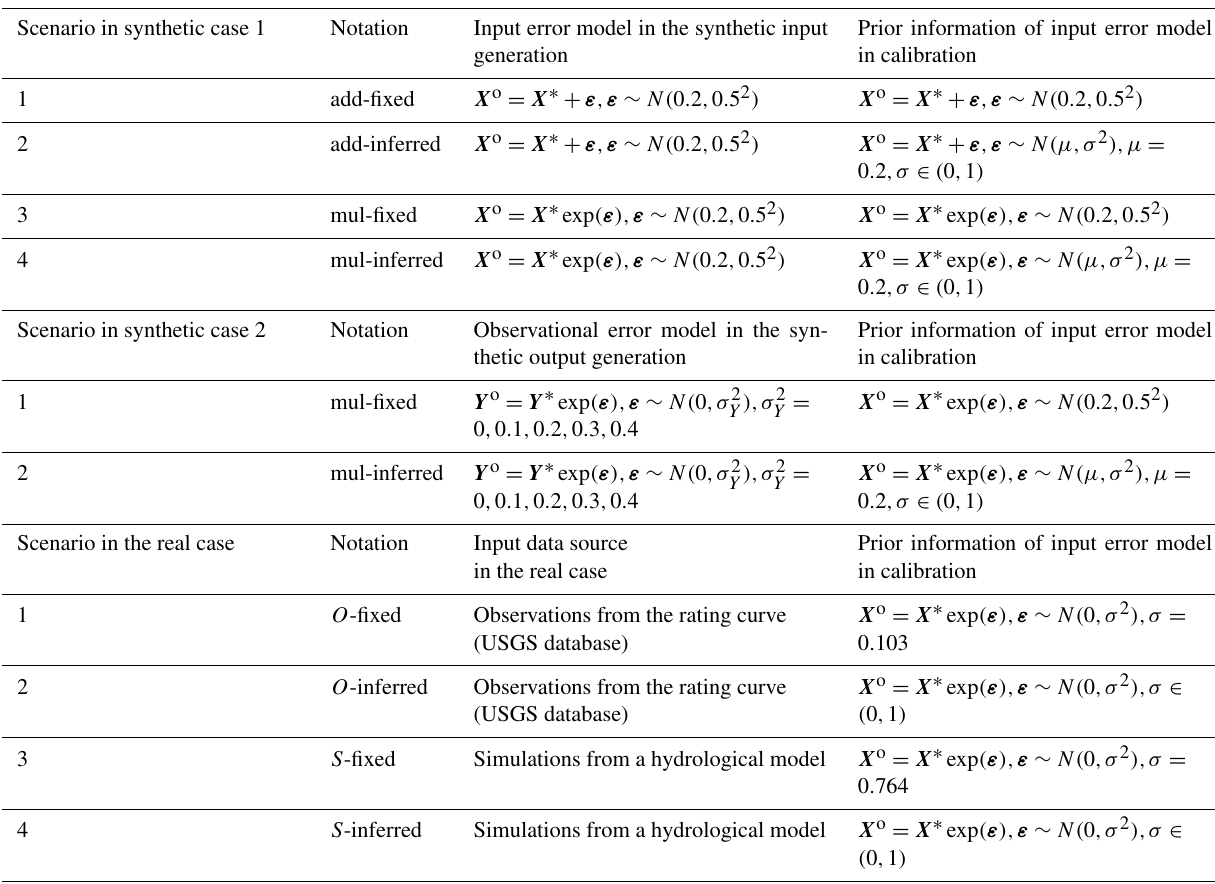
Table 2. Summary of the calibration scenarios in case studies.